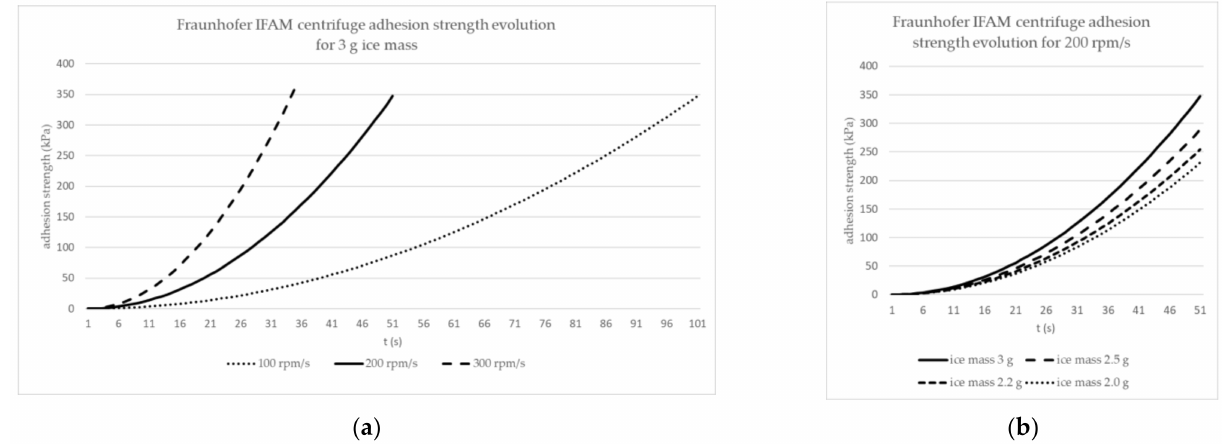
Figure 4. Adhesion strength evolution in the Fraunhofer IFAM centrifuge for: ( a ) 3 g of ice at various acceleration speeds; ( b ) 200 rpm/s acceleration speed and various ice